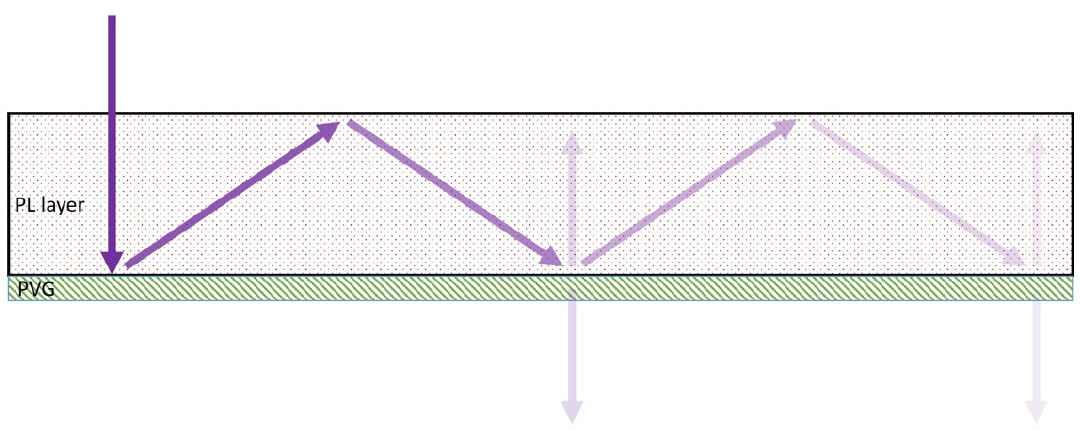
Figure 8. Schematic illustration of a photoluminescent enhancement film based on PVGs.